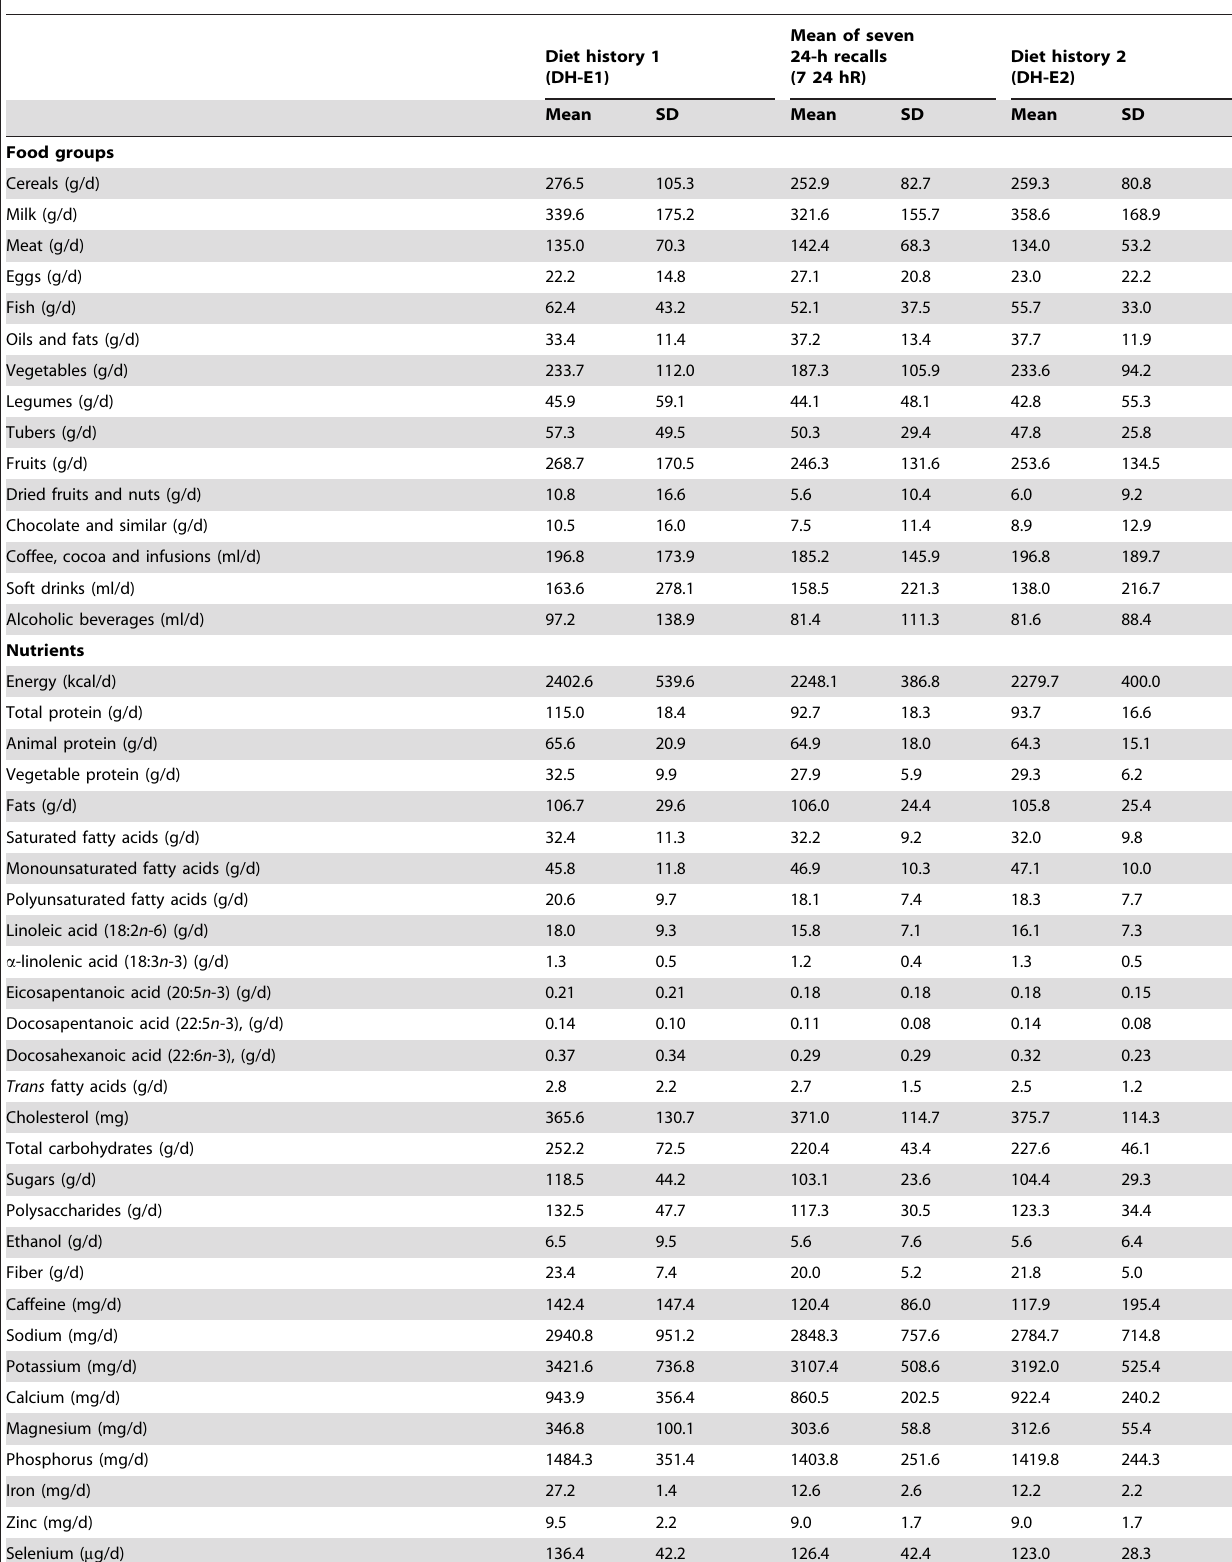
Table 2. Food and nutrient intake according to DH-E1 (at study baseline), mean of seven 24-hour recalls during one year, and DH-E2 (at 12 months from baseline). (N